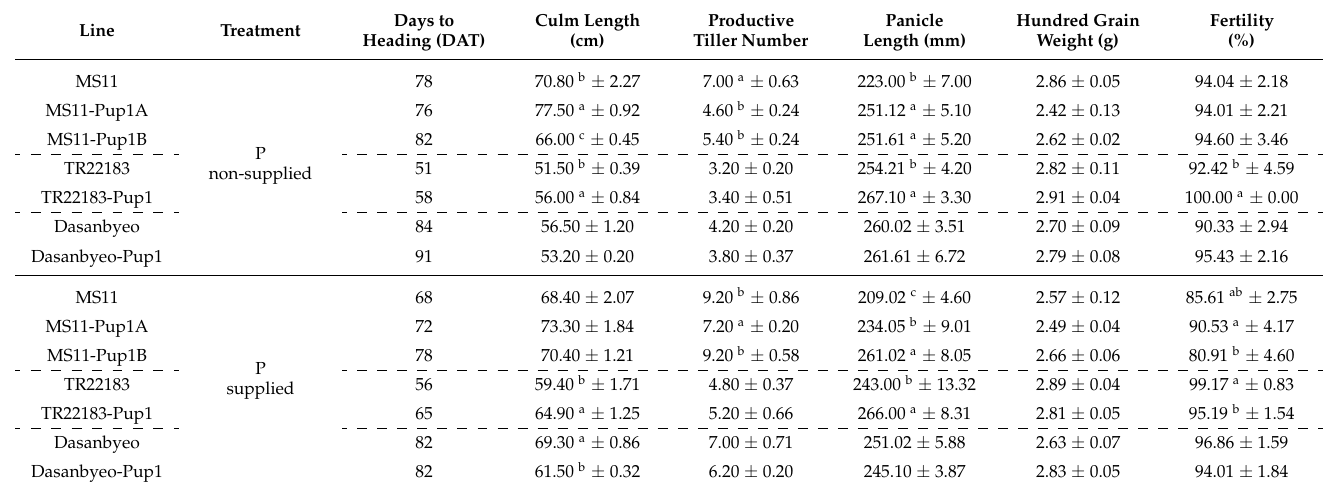
Table 4. Reproductive stage response of temperate-Pup1 introgression lines and control varieties grown under rainfed and irrigated conditions (2022). Means with the same letters within a genetic background and treatment not significantly different using DMRT at p = 0.05, except for days to heading. Values are means ±